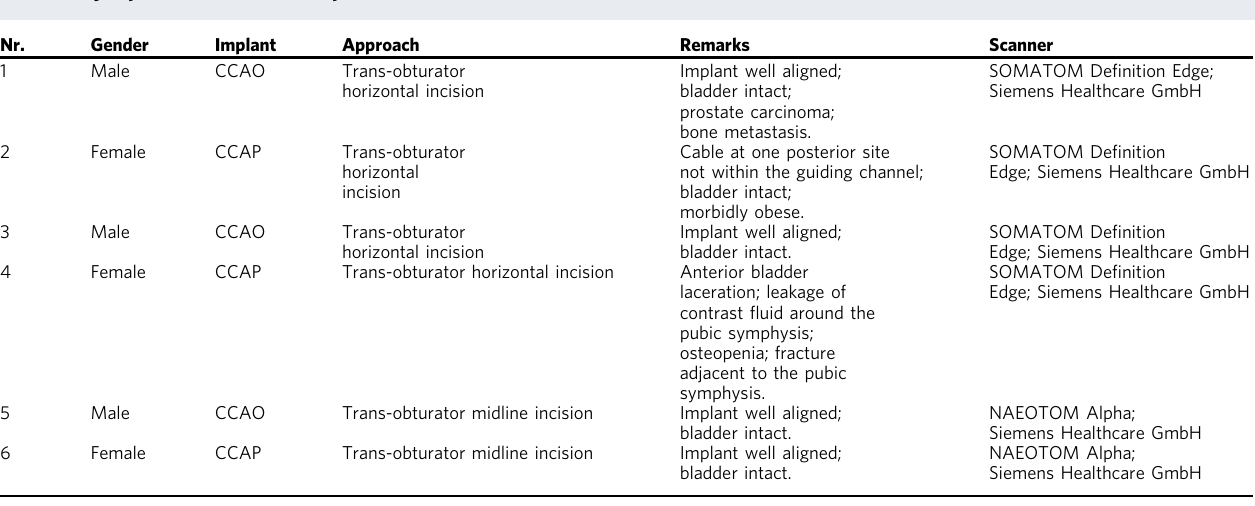
Fig. 3 Biomechanical testing setup. A A synthetic bone model, fi xed with one of the developed implants, was mounted to the material testing machine. A single-leg stance test with uniaxial load was used. B Visual markers were placed around the pubic symphysis and iliosacral joints and their motion was tracked using a camera system. The material testing machine measured the displacement of the whole pelvis, whereas optical video analysis was used to measure bone movement at the pubis symphysis. The methods of attachment ( C ) and optical measurement ( D ) of cadaver bones were similar to those used for the synthetic bone models. Colored arrows in panels ( B and D ) indicate movements along the y -axis. The number of cycles used to test cadaver bones was lower than that used for testing the synthetic bone models because of the limited time available after cadaver specimens were defrosted. Table 2 Synopsis of the cadaver